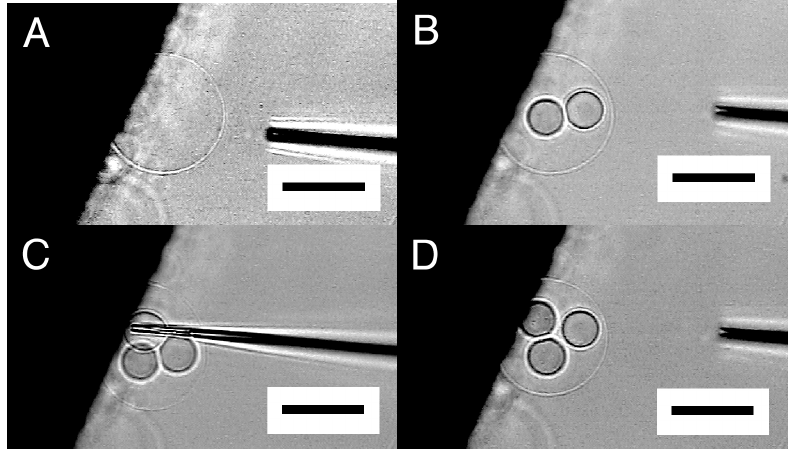
Figure 4. Formation of multiple inner GVs in a single semi-sphere. Images are the semi-sphere before microvesiculation ( A ), two inner GVs already formed by repeating the procedure ( B ), the third GV in formation ( C ), three GVs inside ( D ). Bar = 50 μ